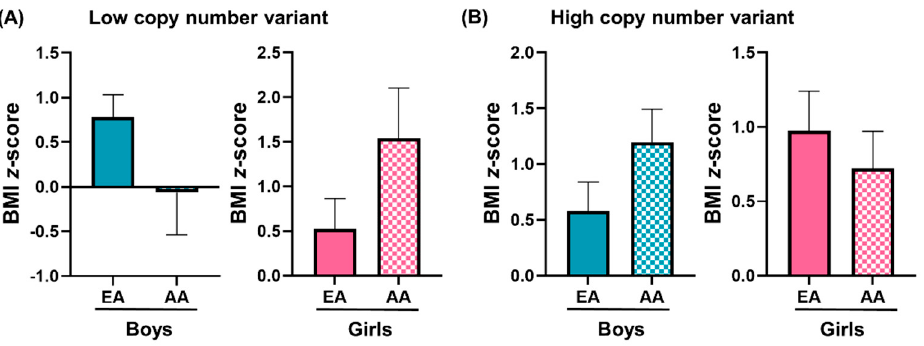
Figure 4. BMI z -scores of boys and girls with low copy number variant (LCNV) and high copy number variant (HCNV) of White/European American (EA) and African American (AA) ethnicities. ( A ). BMI z -scores of EA and AA boys and girls with LCNV. ( B ) BMI z -scores of EA and AA boys and girls with HCNV.